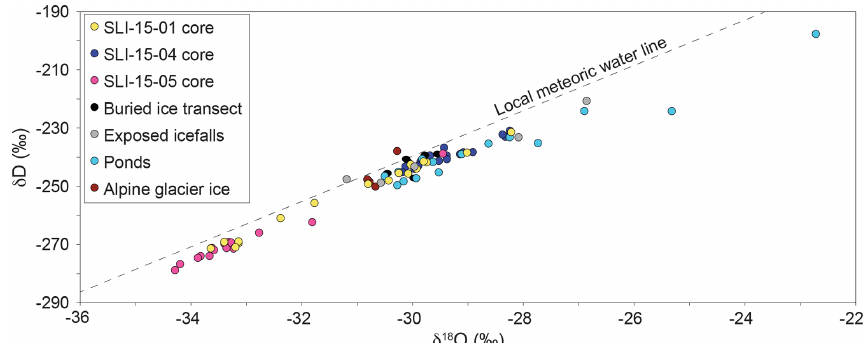
Figure 9. Plot of δ 18 O vs. δ D of 59 samples from the rock glacier. Cores 01, 04, and 05 were gathered from buried ice along a longitudinal transect down the central flow line of the rock glacier. Buried ice transect refers to additional hand samples KWL-15-11 to KWL-15-15 (see Fig. 8 for locations). Exposed icefalls were five samples from two locations (SLI-15-08 and SLI-15-09; Fig. 8). Samples were also gathered from seven ponds along the rock glacier surface (SLI-15-02, SLI-15-06, SLI-15-10, SLI-15-16, SLI-15-17, SLI-15-18, and SLI-15-19; Fig. 8) and two local alpine glaciers, Sollas and Doran. The local meteoric water line is from Gooseff et al. (2006).